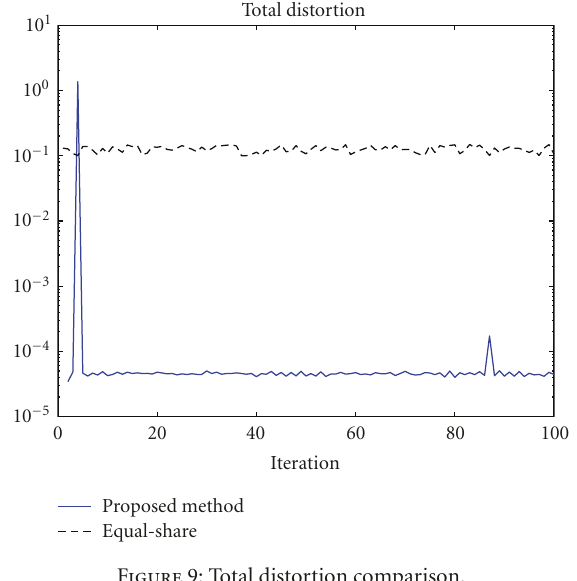
Figure 9: Total distortion